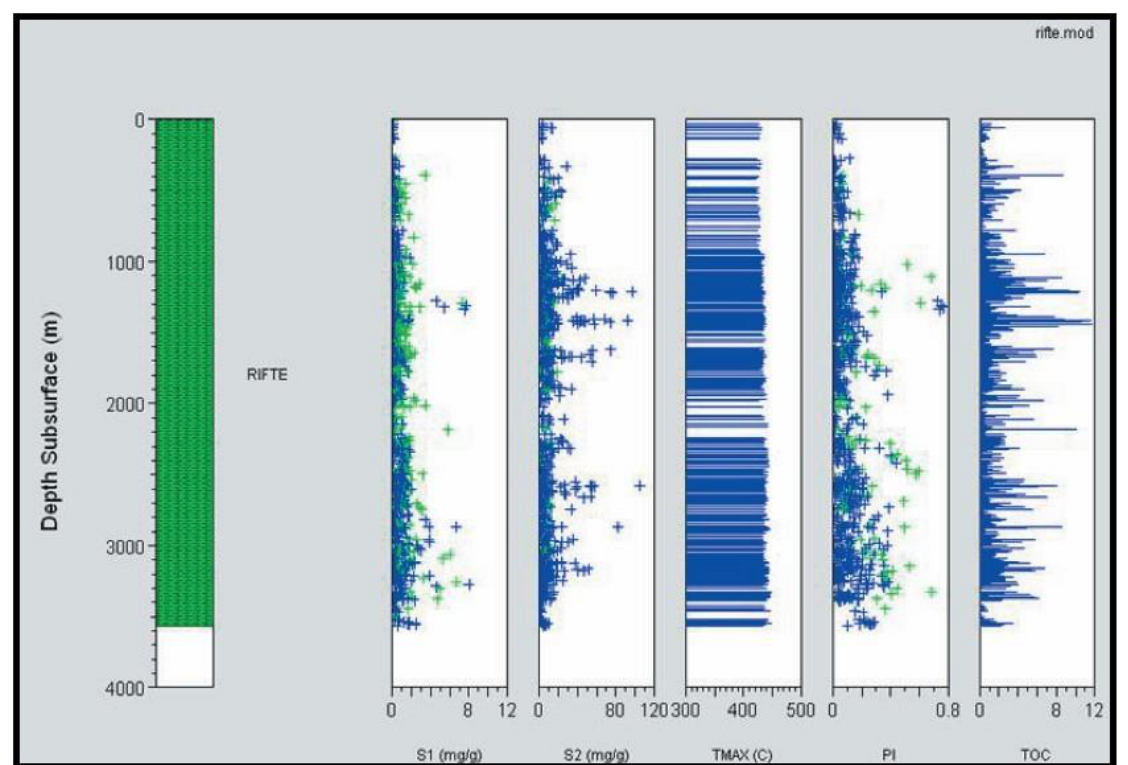
Figure 12. Geochemical profile of the Lagoa Feia Formation representing the sum of all geo- chemical information regarding this unit